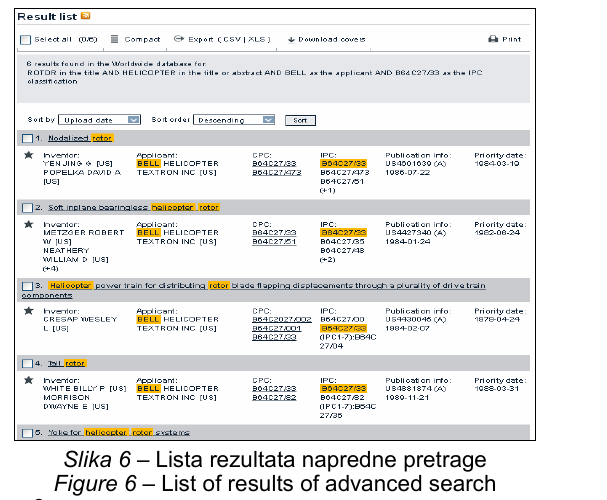
Рис . 6 – страница с результатами расширенного